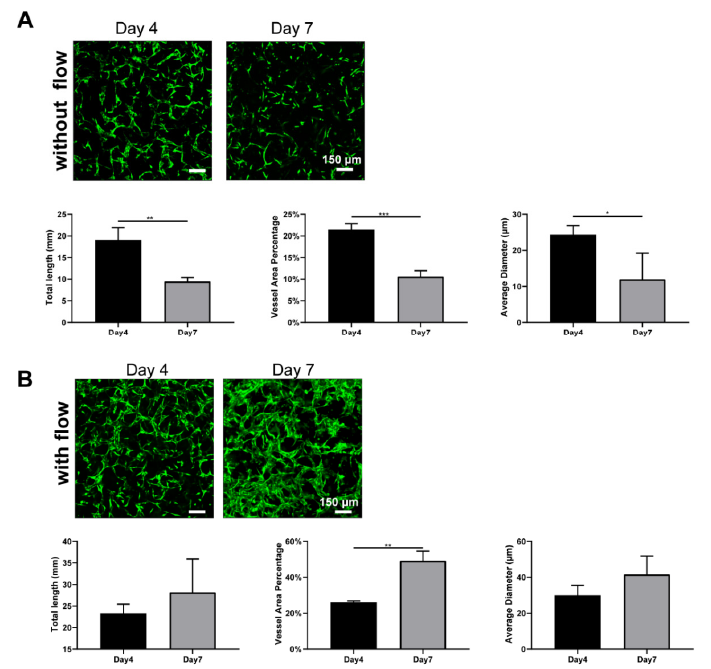
Figure 6. Fluorescent images of constructed vasculatures without ( A ) or with ( B ) flow on day 4 and day 7, and morphological statistics over 7-day period. n = 3 and data were presented with average value ± standard deviation. p -Values were calculated using the student’s t -test. *, p < 0.05; **, p < 0.01; ***, p < 0.001. Scale bar: 150 μ m.